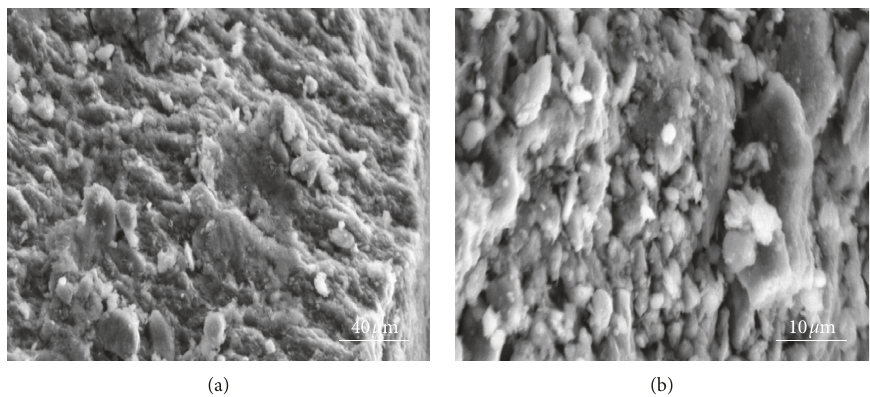
Figure 4: View by scanning electron microscopy of purified clay (AP).